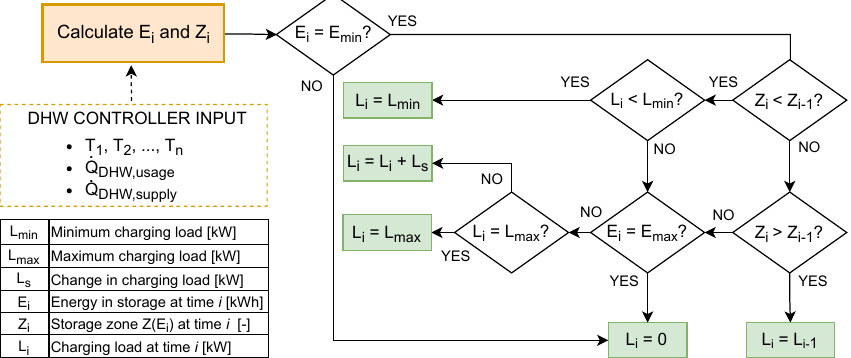
Figure 4. Simplified decision tree control logic to determine DHW charging load with the aggressive charging strategy.